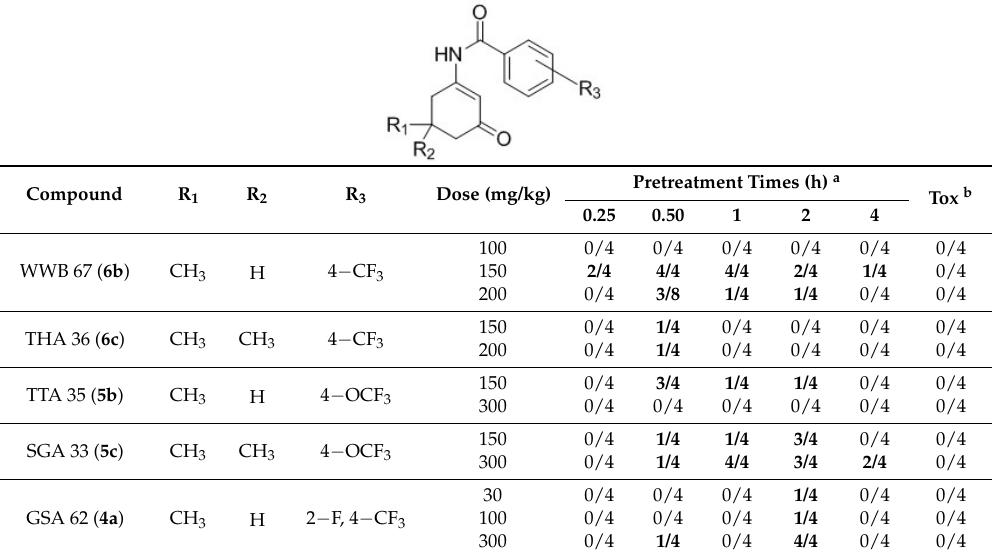
Table 3. Anticonvulsant activity: 6-Hz 44-MA test in mice.